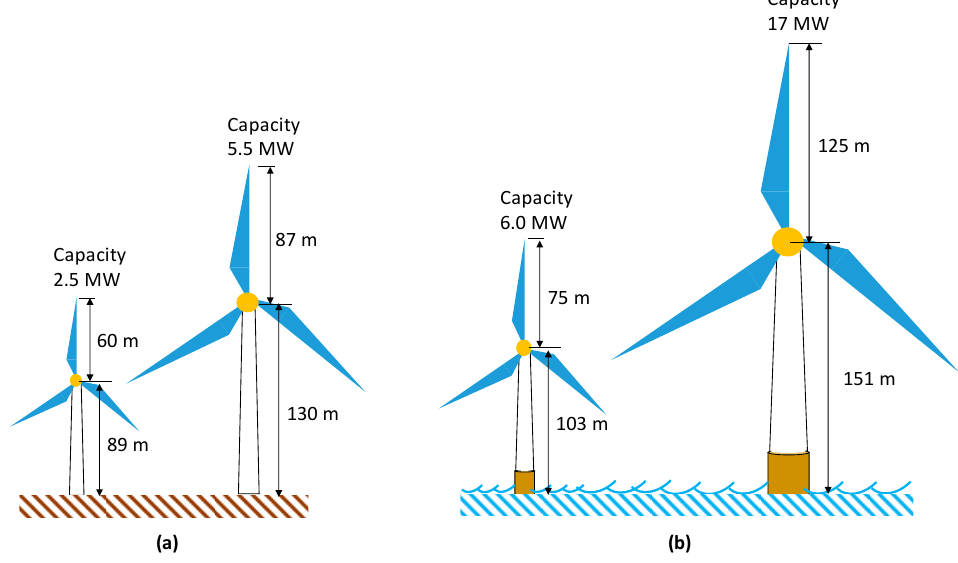
Figure 1. Expected turbine size in 2035 for onshore and offshore wind, compared to 2019 medians: ( a ) onshore wind turbines and ( b ) offshore wind turbines.